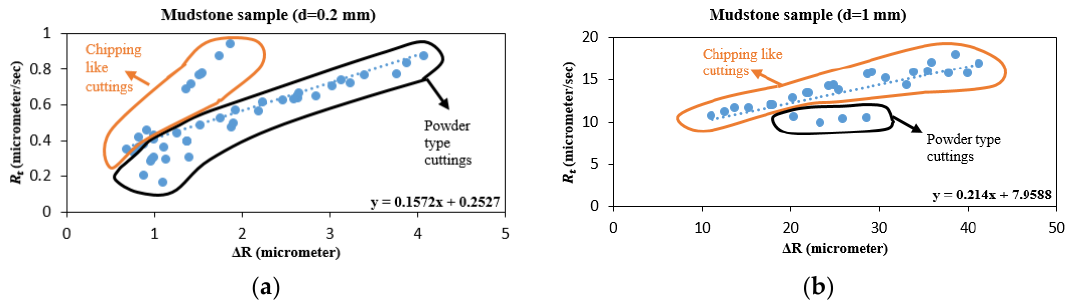
Figure 30. The number of chipping like cuttings and powder type cuttings at different DOCs: ( a ) d = 0.2 mm; ( b ) d = 1 mm.